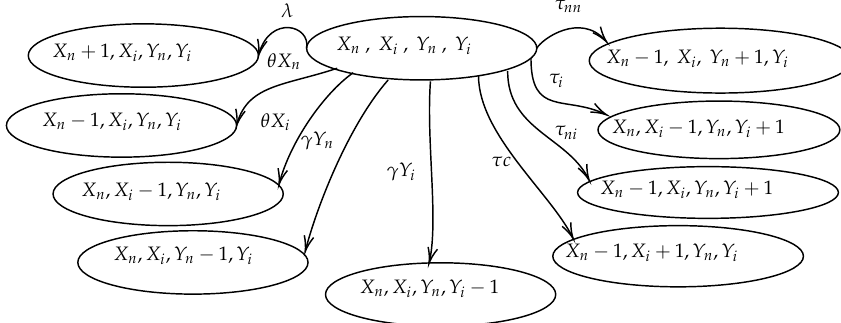
Figure 5. Markov chain of the infection process in a P2P system.